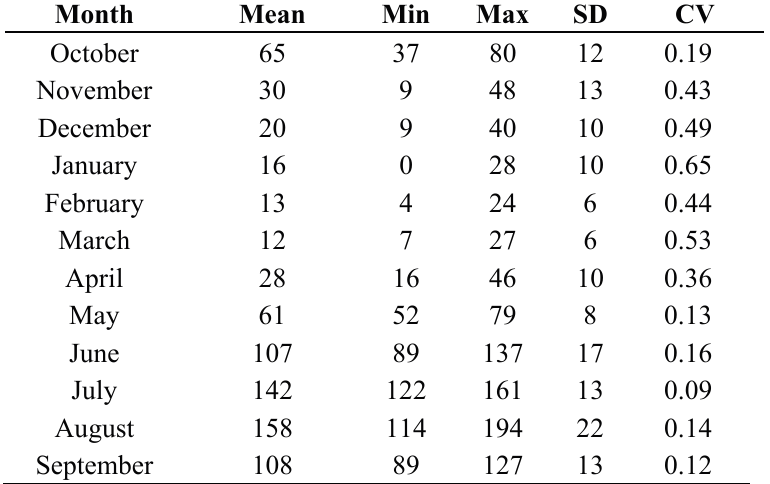
Table 6. Monthly mean, minimum, and maximum evaporation values, along with standard deviations and coefficients of variation for each month in mm from 1996 to